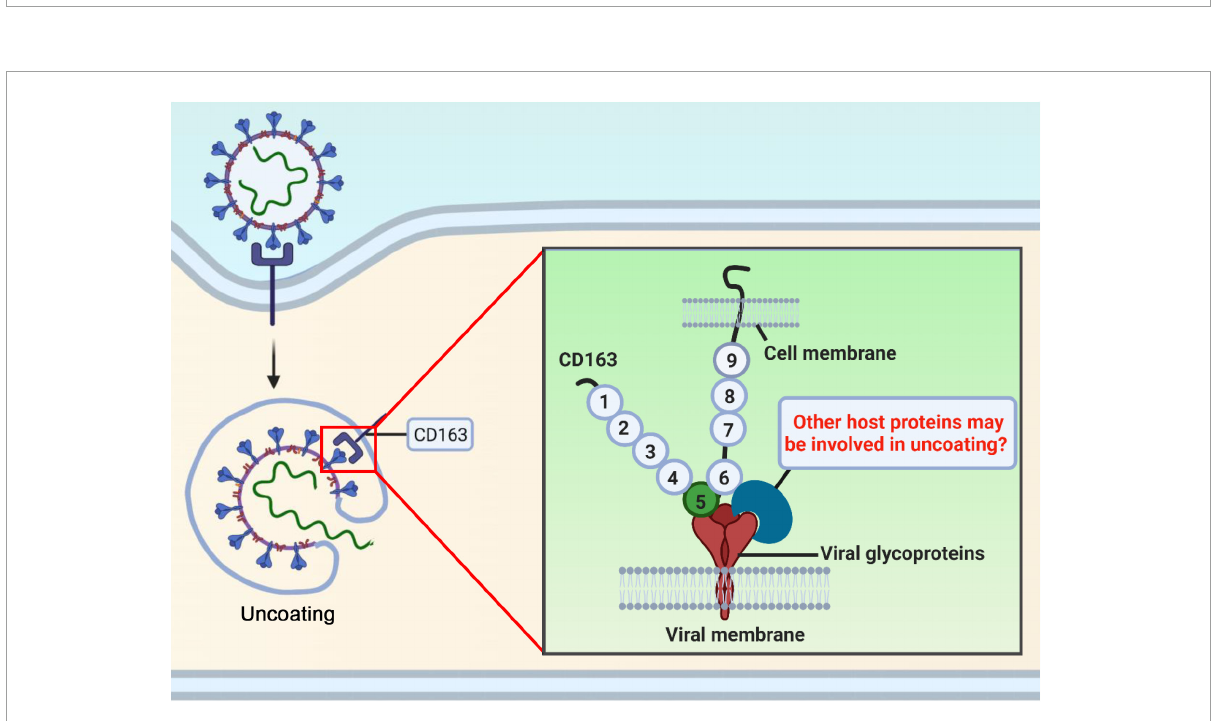
FIGURE3 There may be other potential host cofactors that interact with CD163 to mediate virus uncoating and genome release. CD163 receptor determines whether virions uncoating is occurred in PRRSV life cycle. However, the molecular mechanism of uncoating remains largely unclear. Other molecules may participate in this process, which could be used as targets for gene-editing to render pigs resistant to